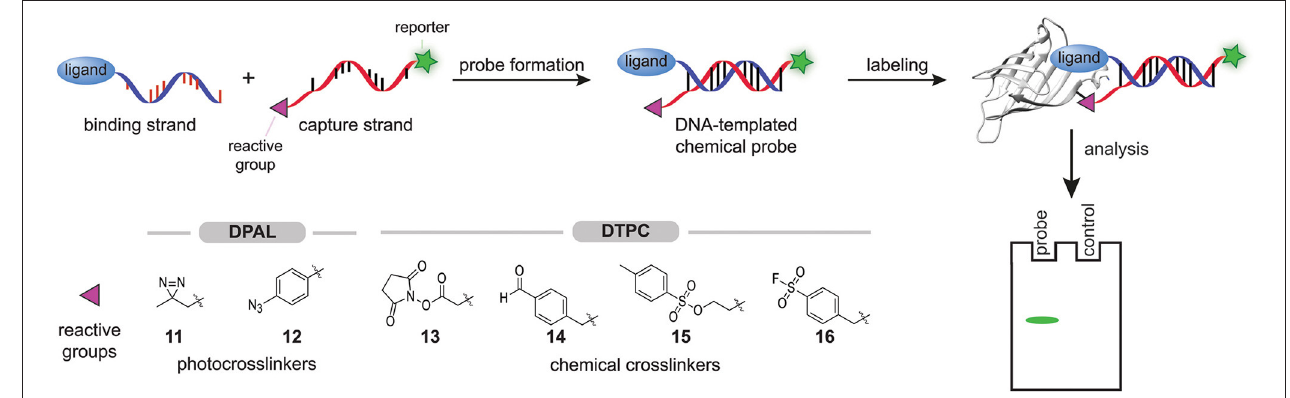
FIGURE 4 | Schematic representation of the modular synthesis of chemical probes by DNA-technology. A binding strand, functionalized with a ligand that binds selectively to the protein of interest, is hybridized with a capture strand that contains a protein reactive group. In DPAL, the 3 ′ of the capture strand is functionalized with one of the depicted photocrosslinkers and the 5 ′ -end of the capture strand contains a reporter group. In DTPC, the 3 ′ of the capture strand is functionalized with one of the depicted chemical crosslinkers and the 5 ′ -end of the capture strand contains a reporter group. Upon binding of the ligand, the reactive group on the capture strand will covalently modify the protein of interest. The labeled proteins can be visualized via the reporter group on the capture